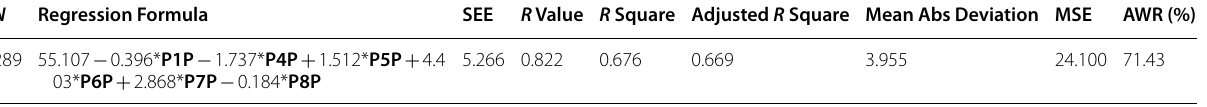
Unit in centimetre (cm) SEE represents standard error of estimation for the generated regression formula; R value represents the Pearson correlation coefficient; Sig. value represents the significant values of the regression ANOVA corresponding to the F value